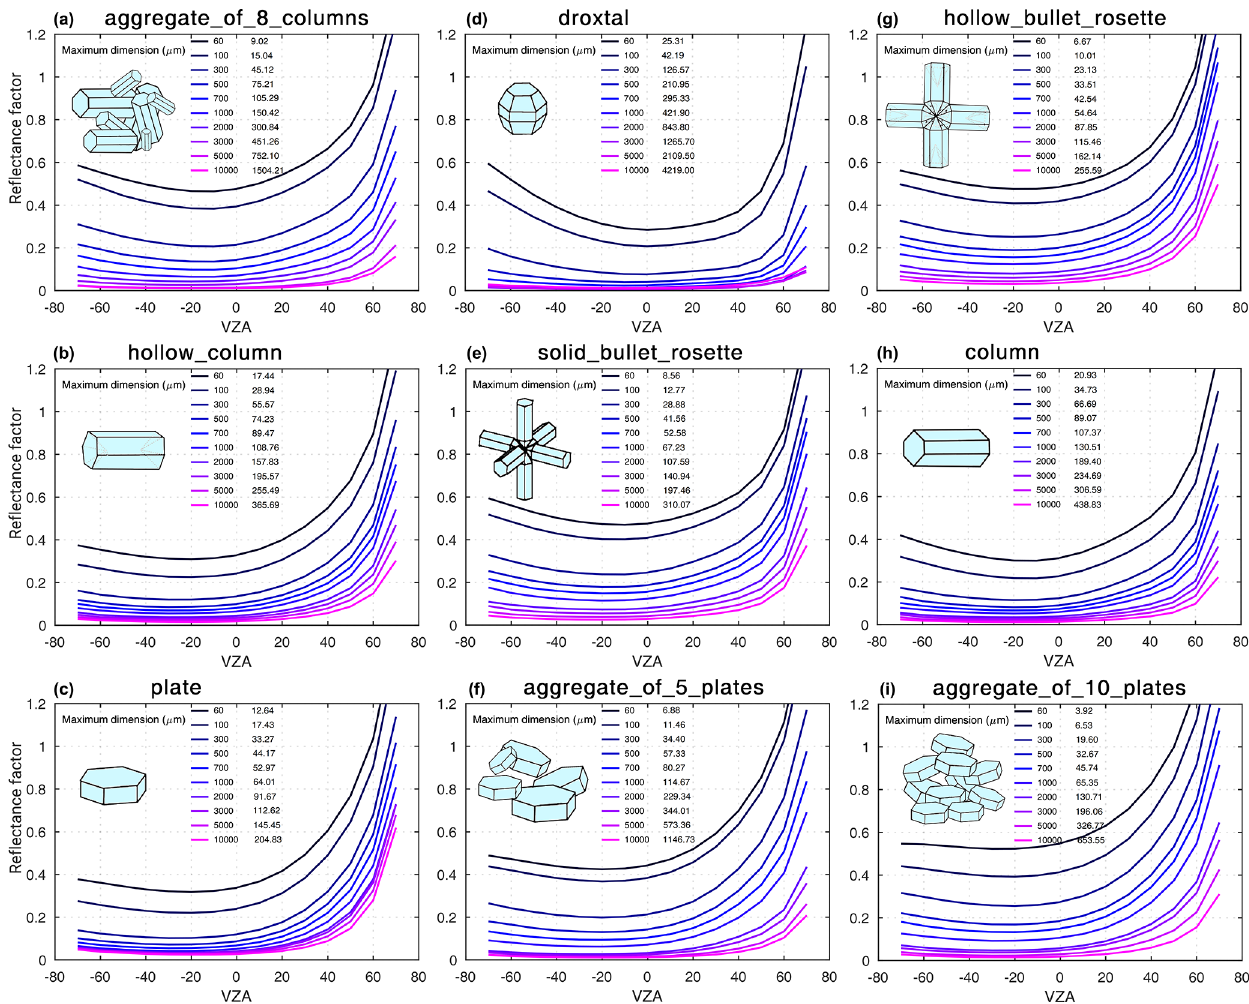
Figure 4. The change in reflectance factor values in the principal plane ( ϕ = 0 and 180) with the size and shape of ice crystals at the wavelength of 1.649µm. The left column of the legend in each panel shows the maximum length of the ice crystal, and the right column is its equivalent effective